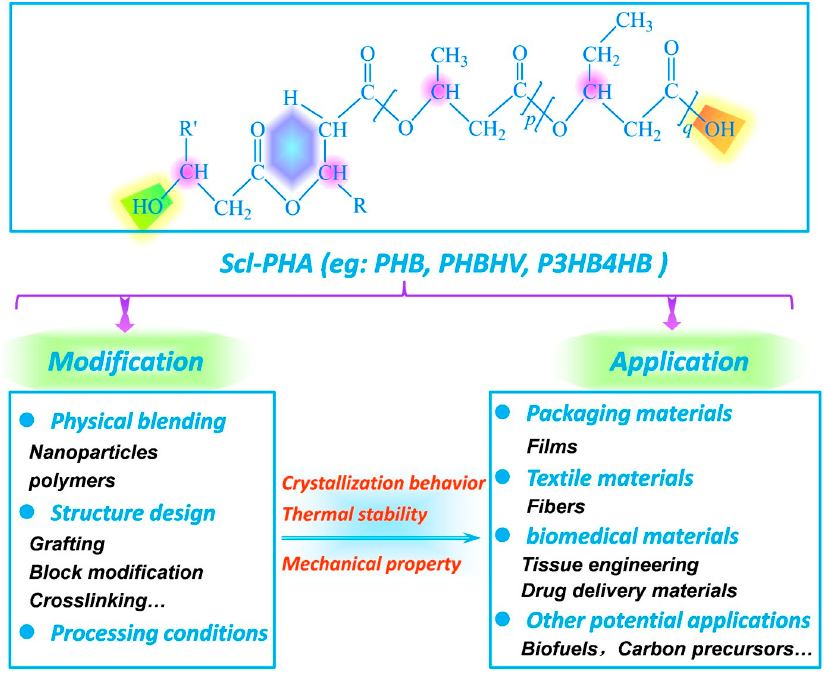
Figure 13. Overview of the modification and application of scl-PHA.